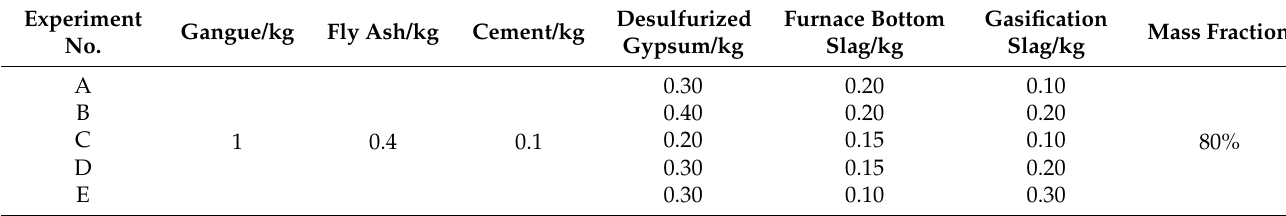
Table 2. Preparation ratio of cemented specimen.